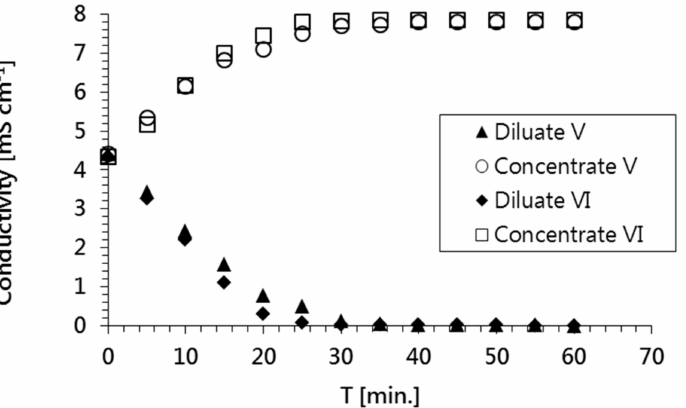
Figure 5. Change in the conductivity of the diluate and concentrate streams during the electrodialysis treatment of solutions No. V and